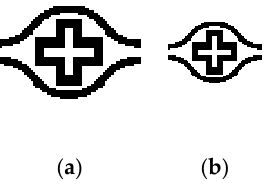
Figure 5. Watermark images used in the experiment: ( a ) 64 × 64 and ( b ) 32 × 32 .